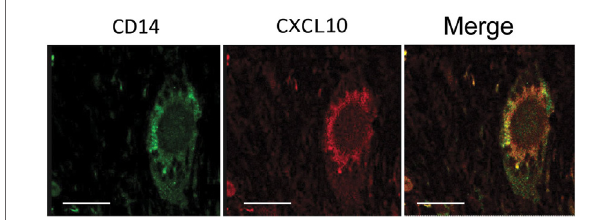
FigUre 7 | CXCL10 expression in multinucleated giant cells. Confocal microscopy analysis of tuberculosis lung sample immunolabeled for CD14 (green) and CXCL10 (red) revealed the presence of CXCL10 in Langhans’ cells, as visible by the co-localization of the two markers in the merged image (merge). Scale bar: 16 µm.